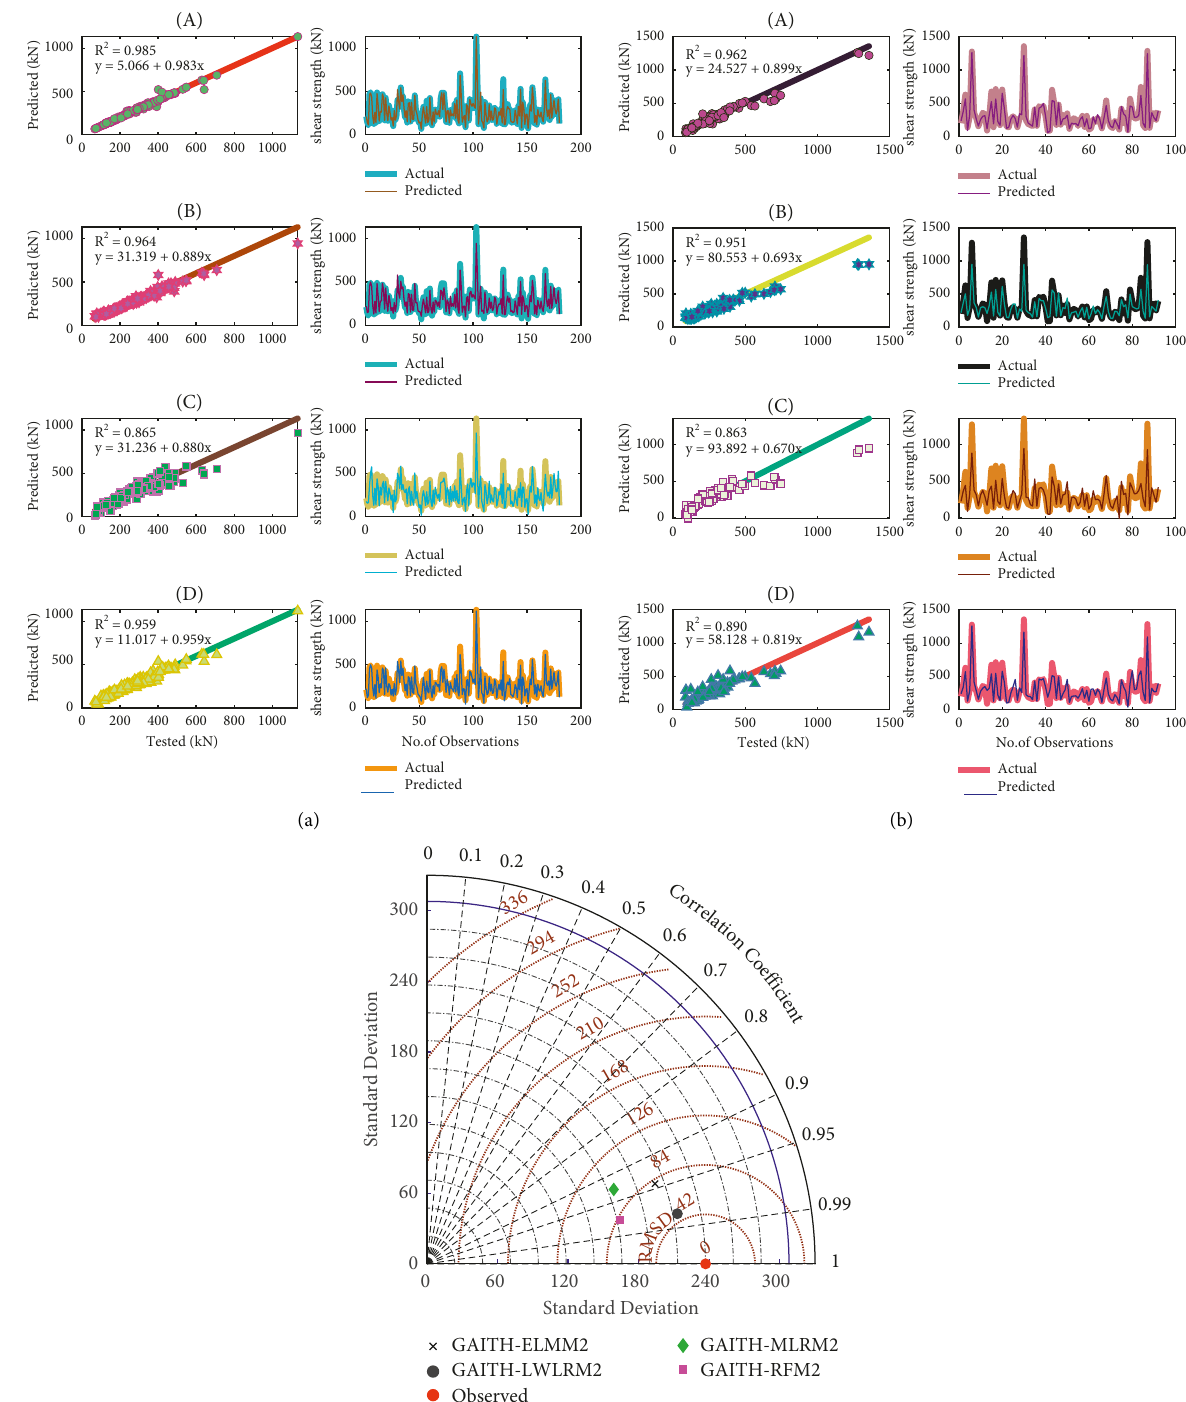
Figure 8: A comparison between the objectives of the models: (A)–(D) represent the GAITH − LWLR , and GAITH − ELM MLR M M 2 models, respectively. Figures (a) and (b) show scatter plots and line plots for the training and test data, 2 respectively, while figure (c) is a Taylor plot based on the test data. (a) Training data. (b) Testing data. (c) Taylor